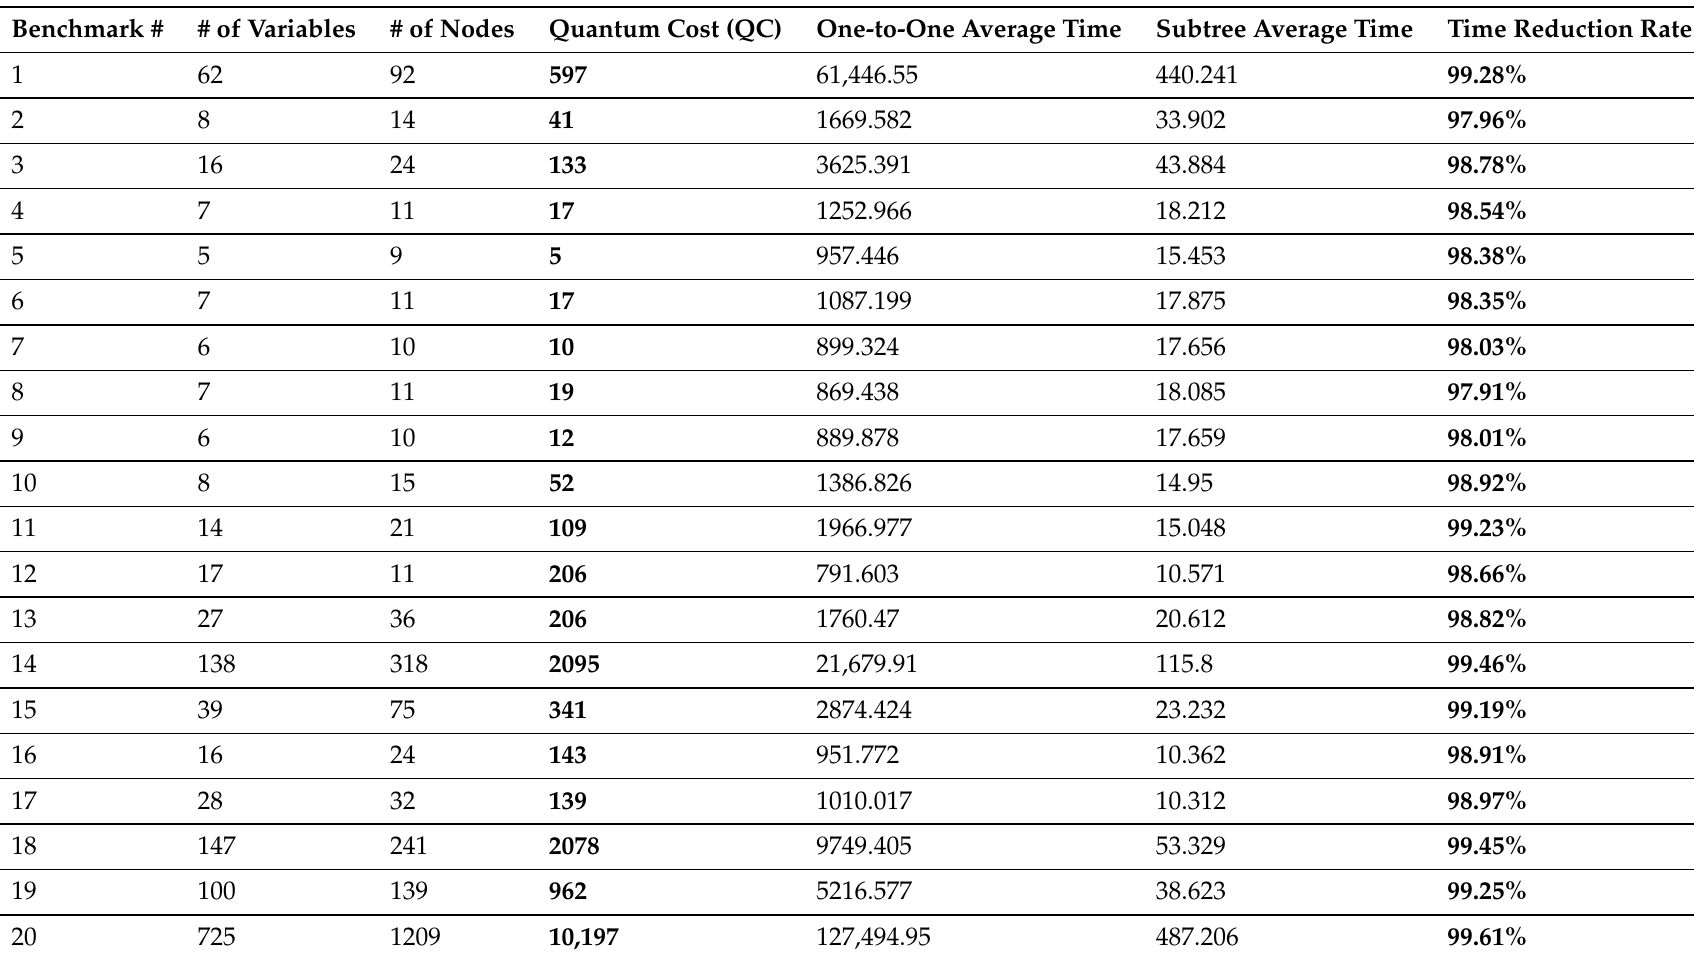
Table 4. One-to-one vs. subtree mapping time